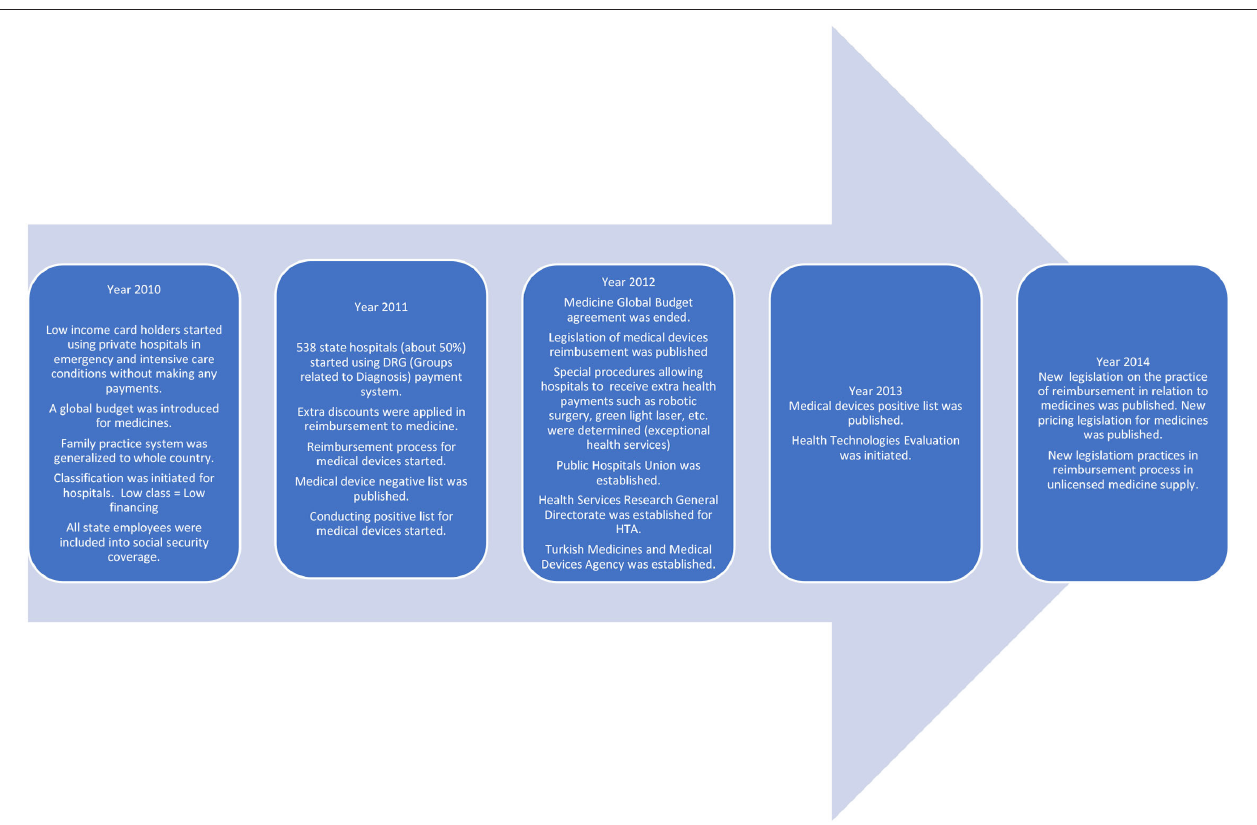
FIGURE 1 | Health Policies that may have an impact on Health Access and Expenditures between 2010 and 2014 (25, 26). Figure 1 is prepared depending on the literature.